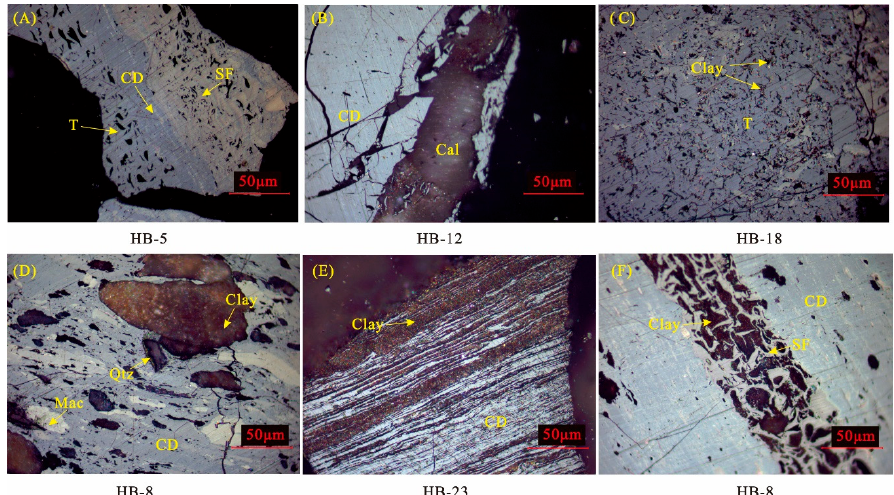
Figure 3. Macerals in the No. 2 1 coal samples. ( A ) Telinite, collodetrinite, and semifusinite in sample HB-5; ( B ) collodetrinite and fracture-filling calcite in sample HB-12; ( C ) telinite and clay minerals in sample HB-18; ( D ) collodetrinite, macrinite, clay minerals, and quartz in sample HB-8; ( E ) collodetrinite and banded-clay minerals in sample HB-23; ( F ) collodetrinite, semifusinite, and clay minerals in sample HB-8. T, telinite; CD, collodetrinite; SF, semifusinite; clay, clay minerals; Qtz, quartz; Cal, calcite.